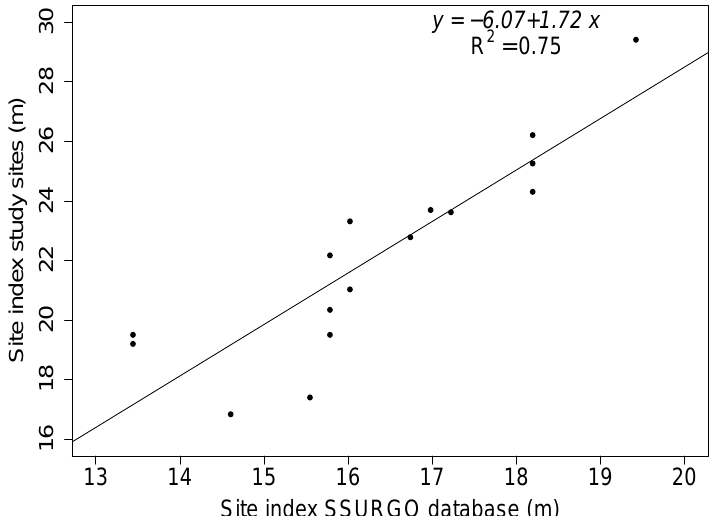
Figure 8. The relationship between SSURGO site index at base age 25 derived from base age 50 using [41] and the site index in the study sites at base age